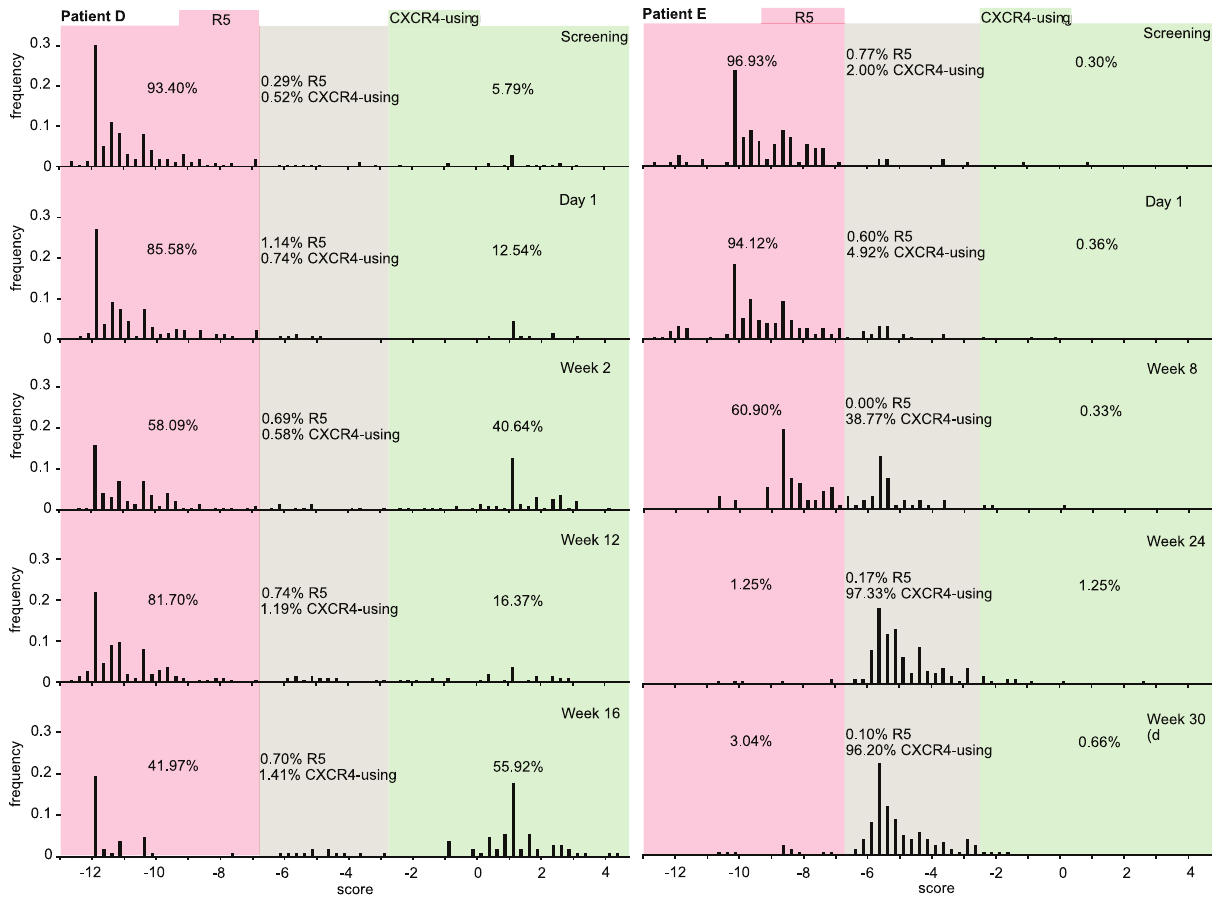
Figure 6. Tropism prediction. Frequency plots of PSSM scores of unique V3 sequences within each dataset. The red area indicates the region below the 2 6.96 threshold (R5), the green region indicates the area above the 2 2.88 threshold (CXCR4-using) and the grey area indicates the region between the two thresholds. The numbers within each plot area indicate the percentage of reads called as R5 or CXCR4-using for that region.